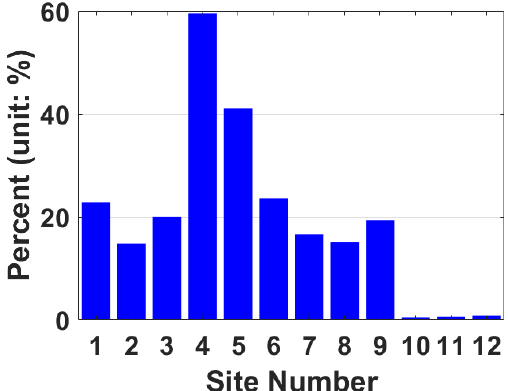
Figure 3. Correlation coefficients of bias time series of the 12 sites.